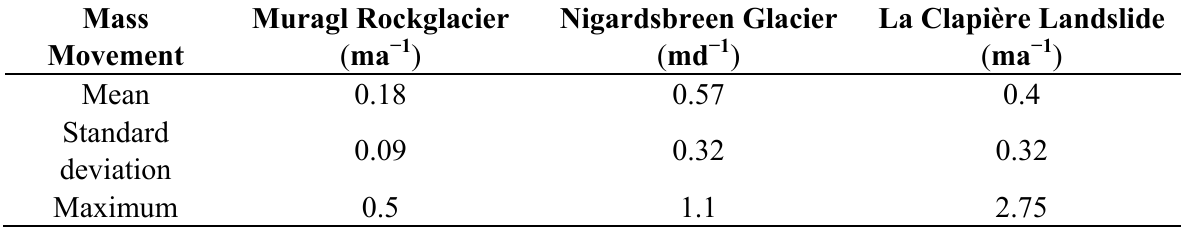
Table 2. Overview statistics for horizontal surface velocity for the three mass movements.